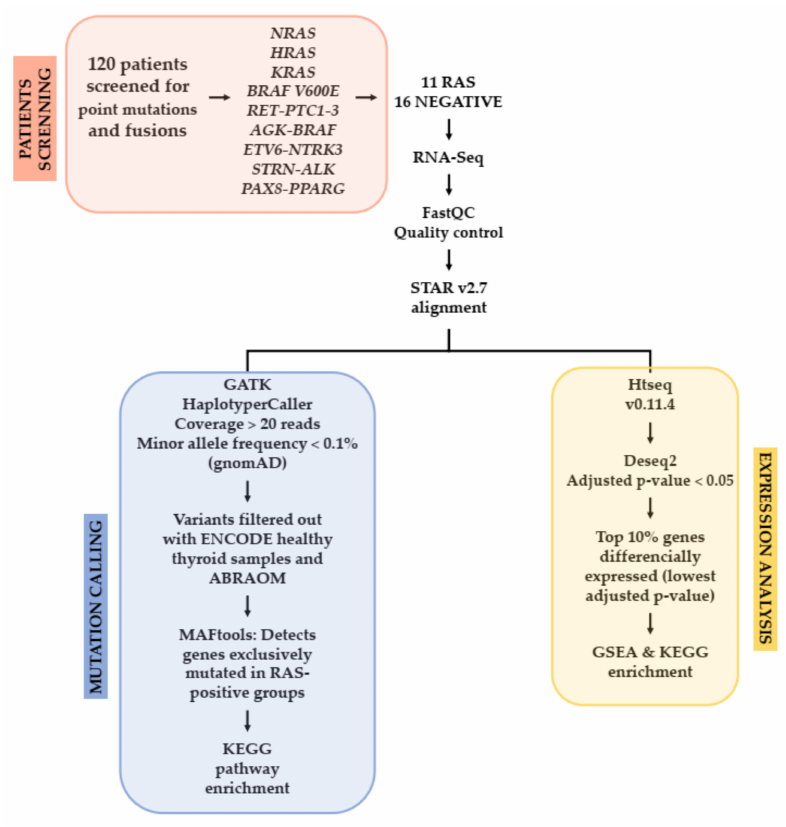
Figure 1. Workflow of the sample selection, screening and RNA-Sequencing pipeline analysis for the discovery